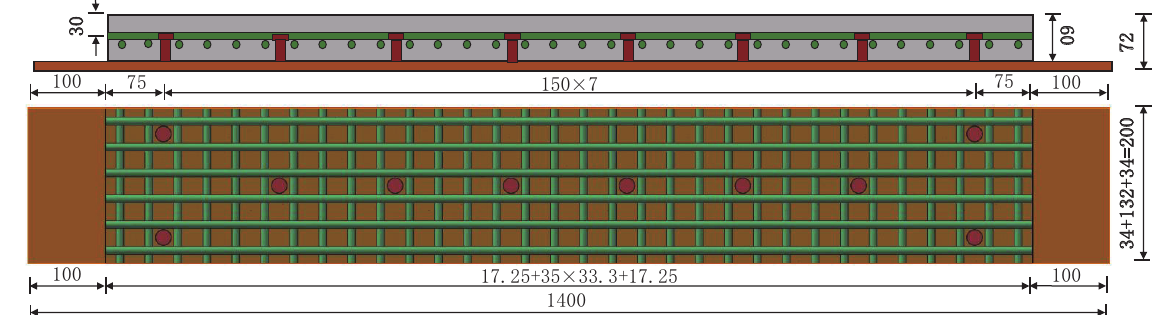
Figure 2. Structural layout of the steel–UHPC composite slab test specimen (unit: mm).